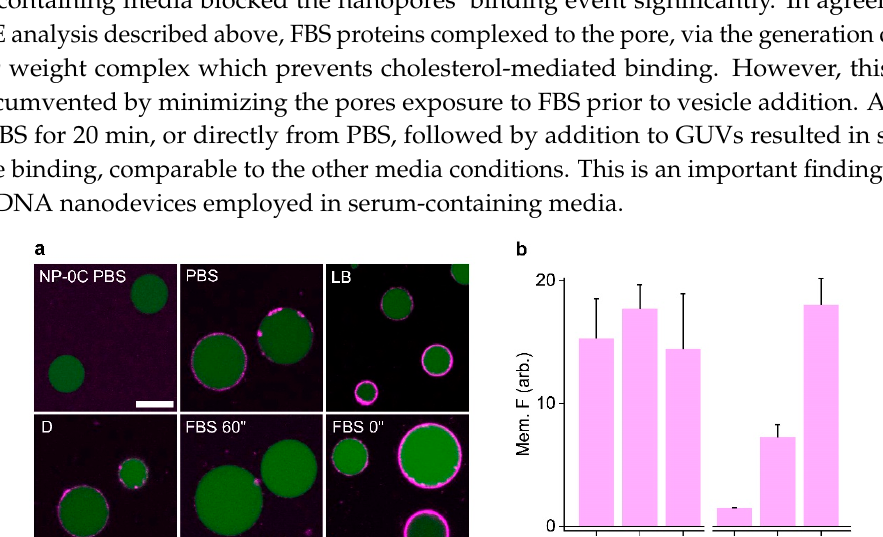
Figure 5. Confocal microscopy shows NP-3C binding to GUVs in biological buffers while FBS complexes to NP-3C to block membrane tethering. ( a ) Cy3-labeled NP-3C ( magenta ) mixed in the stated buffers for 1 h, and NP-3C added to FBS for different time periods, then added to GUVs containing GFP ( green ), image collected after 20mins of pore-vesicle incubation on a glass slide; ( b ) relative membrane fluorescence intensities from ( a ). All images collected under identical conditions. Error bars represent the averages of three experiments. Scale bar 10 µ